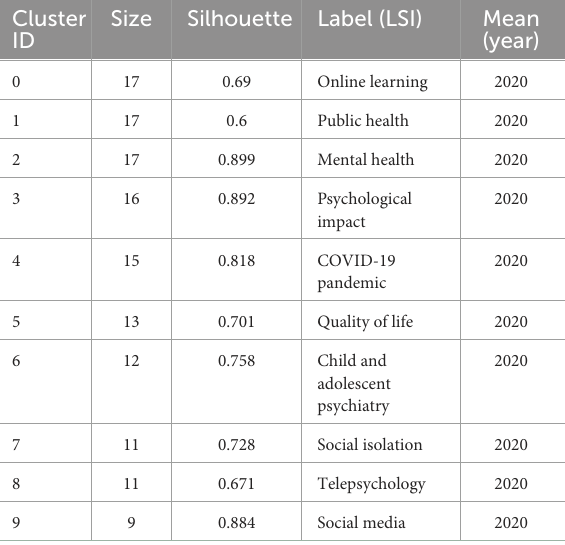
TABLE 7 The largest 10 clusters by